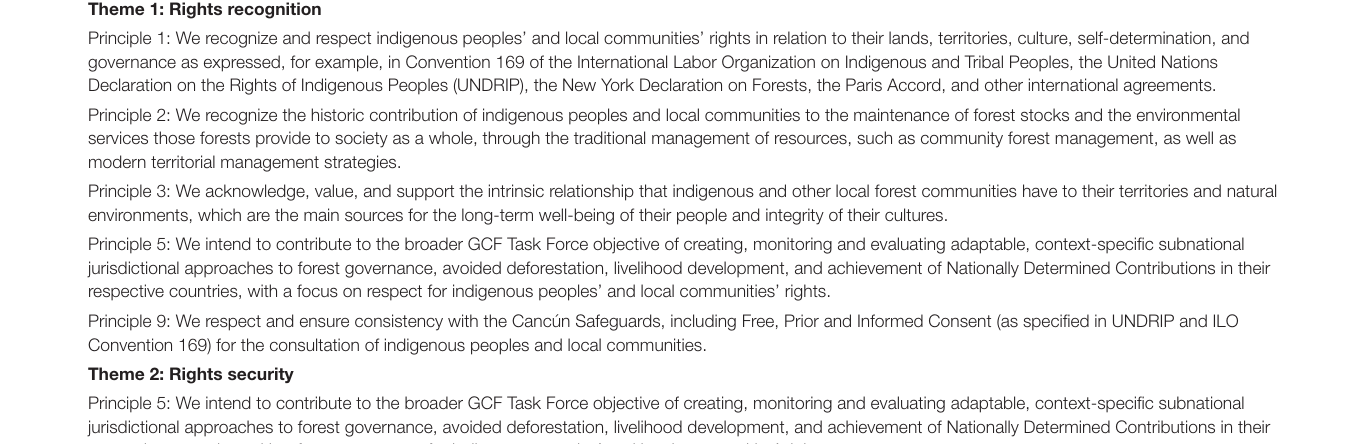
TABLE 1 | The Guiding Principles, organized by the four thematic categories used in our analysis of baseline conditions.